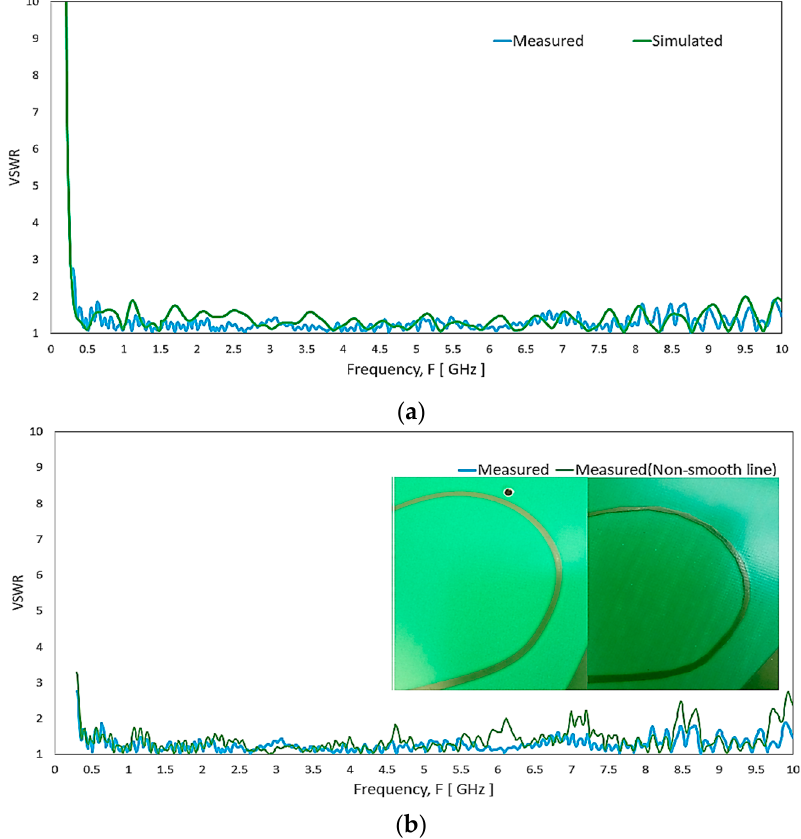
Figure 24. ( a ) Comparison of the simulated and measured VSWR of the antenna. ( b ) The measured VSWR of the antenna with the segmented edge and smooth edge microstrip line.